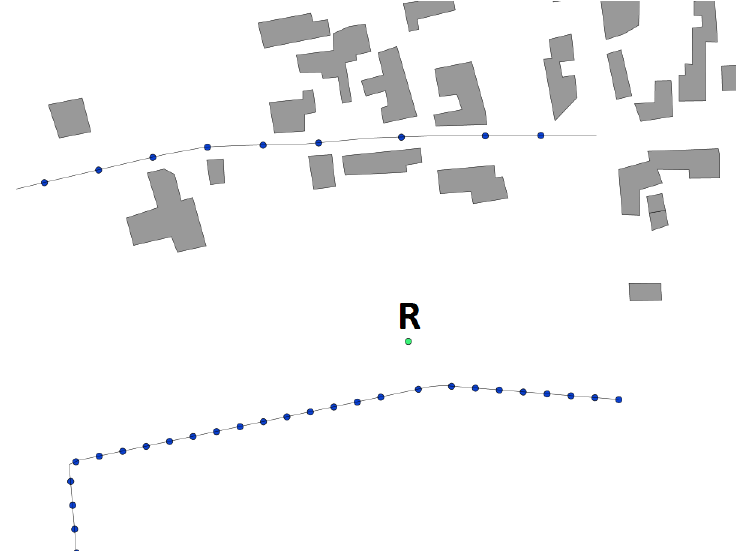
Figure 5. Example of the consideration of the point sources (in blue) for a given receiver R (in green). The discretisation of the line sources depends on the distance from the